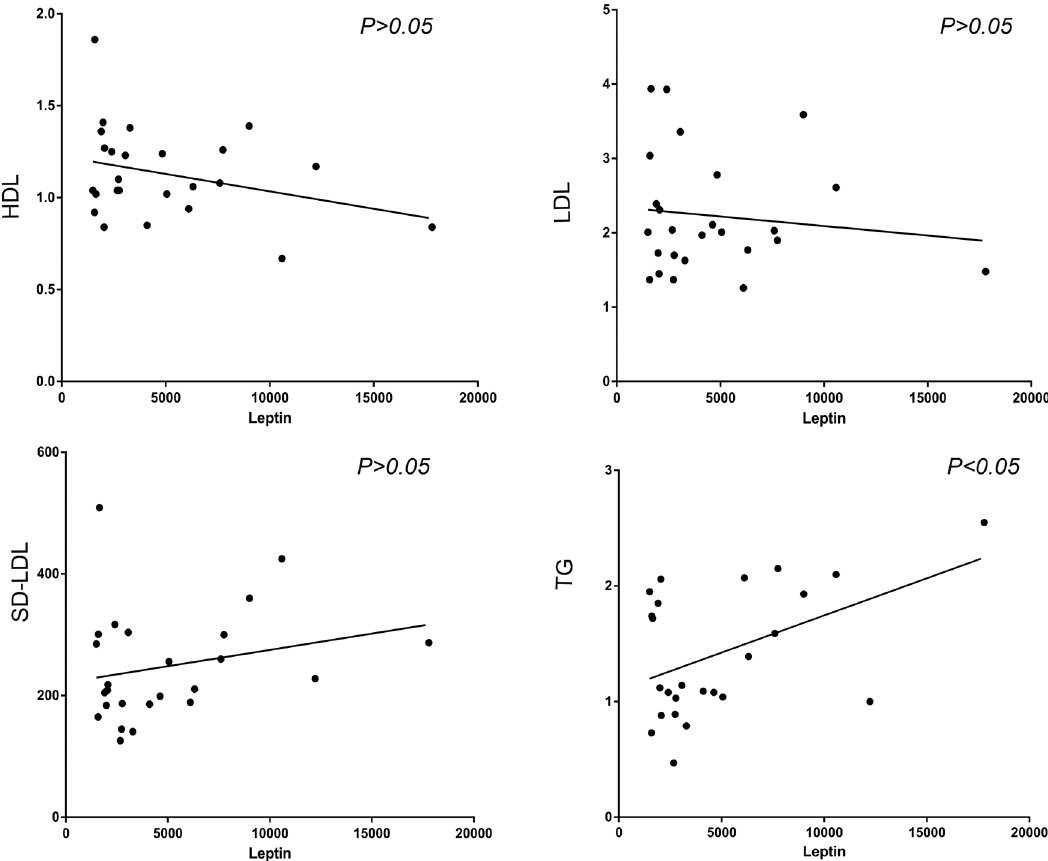
Figure 2: The levels of leptin were positively correlated with blood TG levels. TG: total